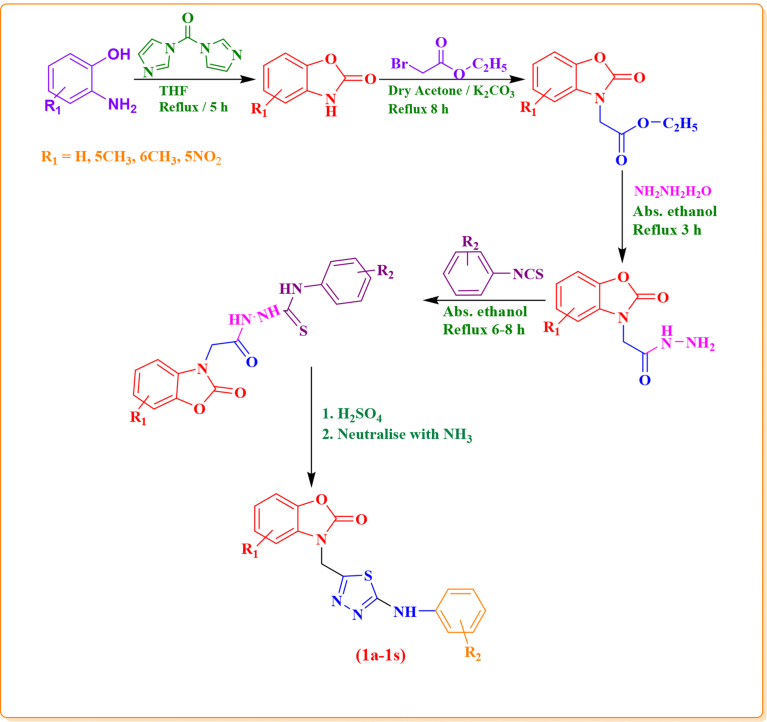
Synthesis of benzoxazolinone-based 1,3,4-thiadiazoles.